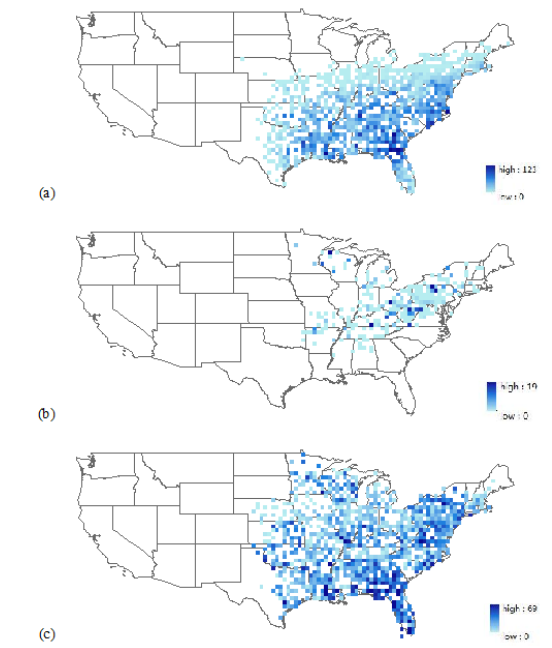
Figure 3. Illustrations of the 0.5° rasterized maps showing the locations of the BBS routes (2014), with different colors indicating the numbers of the birds for (a) Carolina wren, (b) Cerulean warbler, and (c) Red-bellied woodpecker.